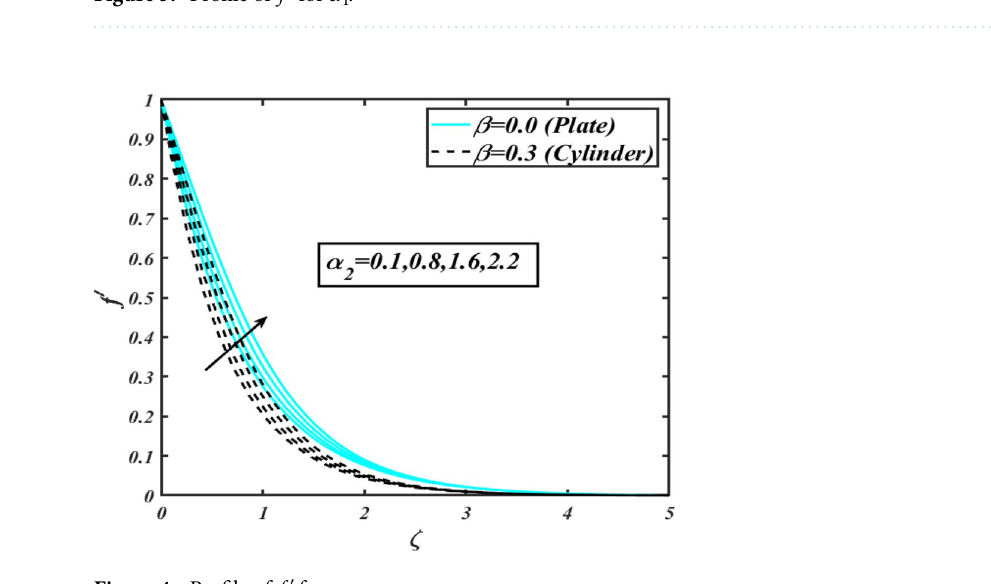
Figure 4. Profile of f ′ for α 2 .